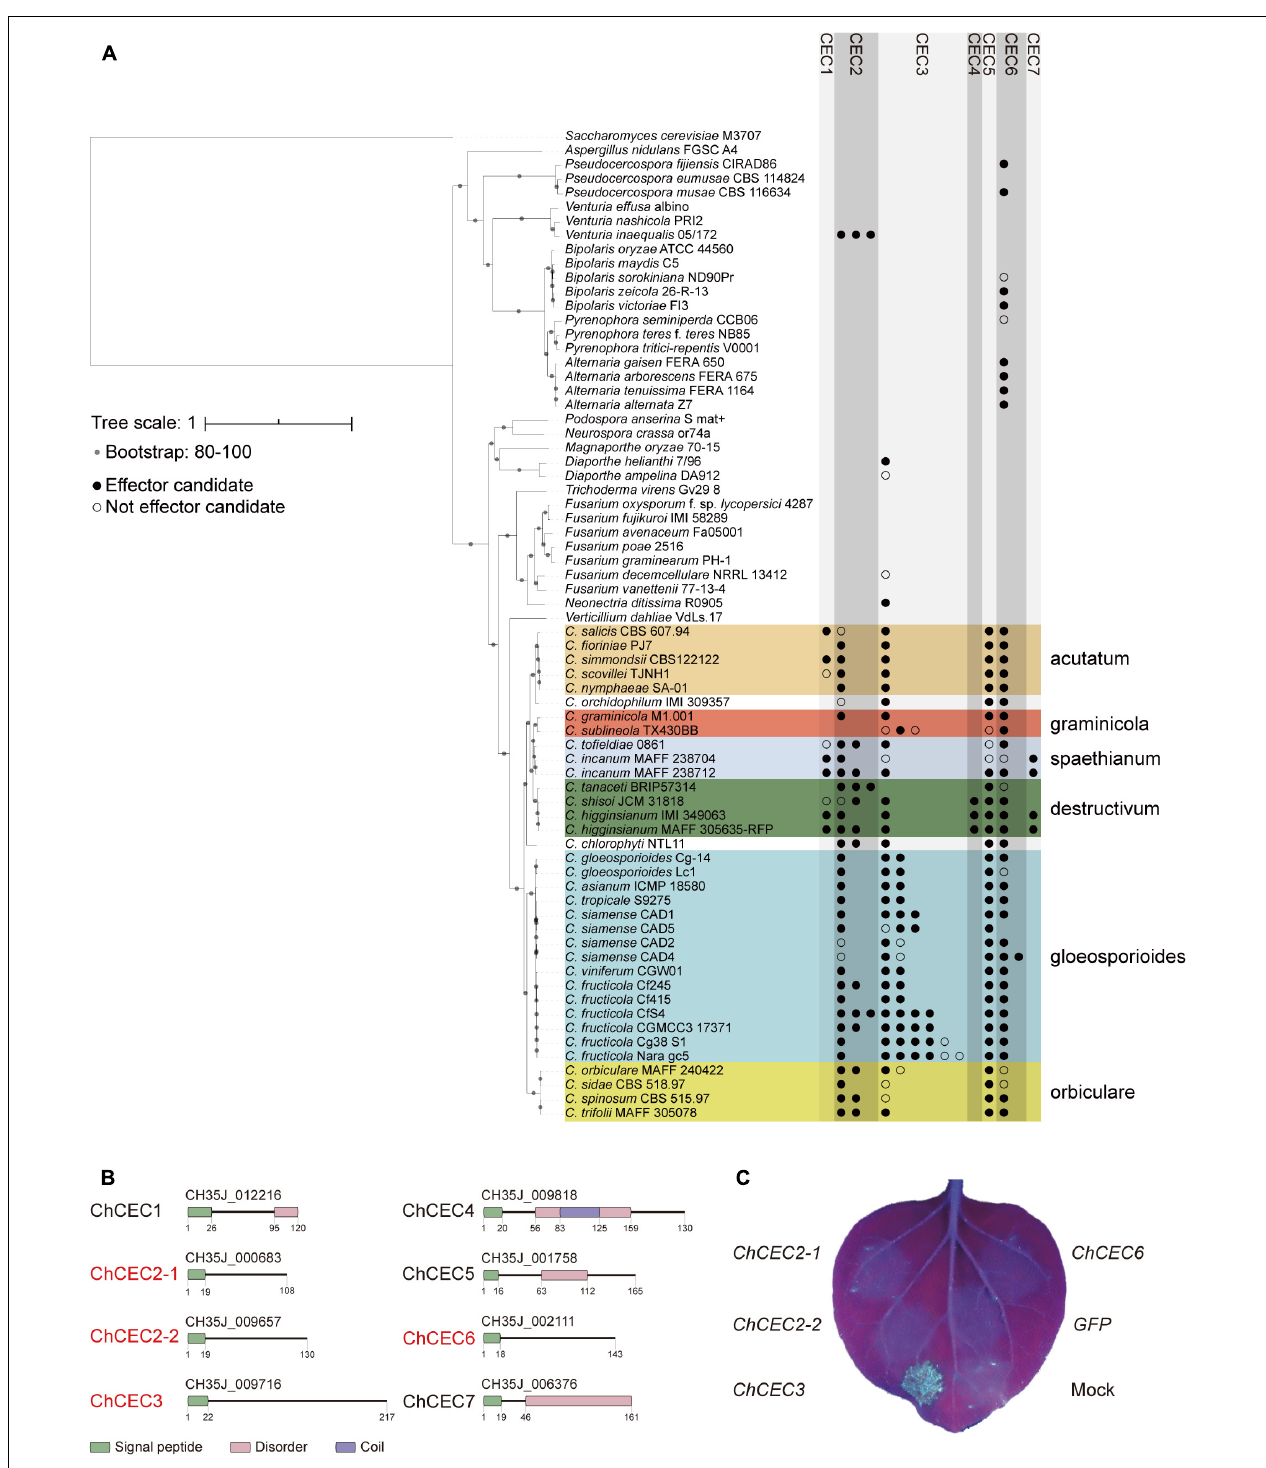
FIGURE 2 | (A) Conservation patterns of CEC genes examined using BLASTP. The maximum-likelihood species phylogeny was drawn based on the alignment patterns of single-copy orthologs obtained using OrthoFinder. Bootstrap values are based on 1,000 replicates. Colored boxes represent species complexes within the Colletotrichum genus. (B) Predicted functional domains of CEC proteins found in C. higginsianum MAFF 305635-RFP. Red letters indicate effector candidates that are up-regulated during infection as reported previously (O’Connell et al., 2012). (C) Representative cell death assay result using A. tumefaciens harboring pSfinx vectors. The image was taken 6 days after infiltration under UV illumination. No GFP fluorescence was visible, as it was weaker than fluorescence from dead leaf tissue.